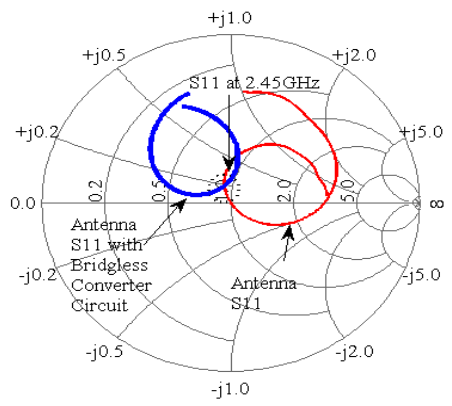
Figure 16. Measured impedance losses of the harvesting antenna without and after attachment of the power processing circuit at 2.45 GHz.